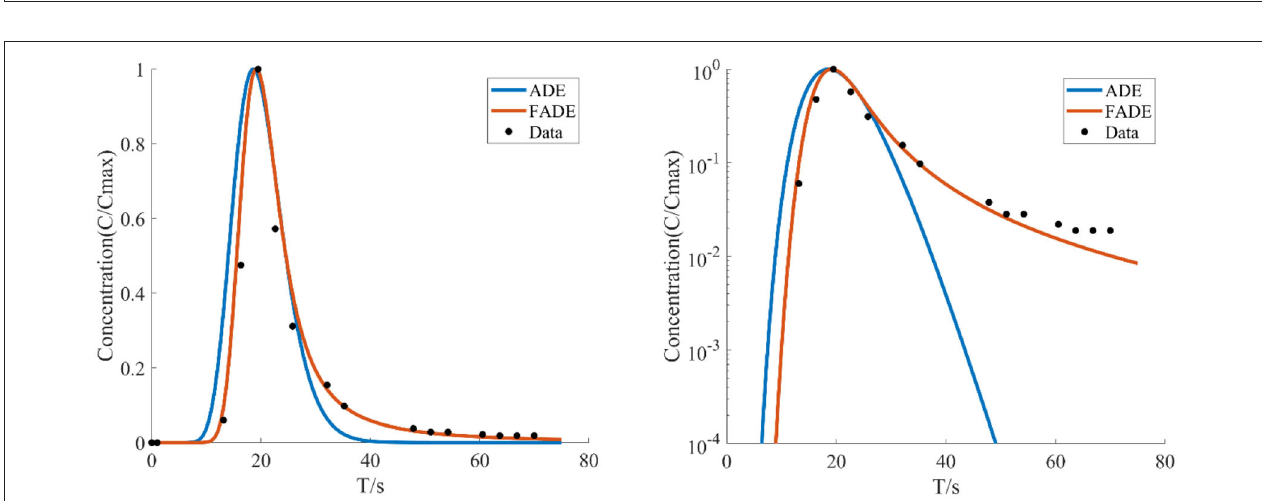
FIGURE 9 | With the average flow velocity v = 31.2064 mm/s, the average fracture width is e = 4.9mm, the concentration of the relative roughness 1 /e is 0.2041 test data, the BTCs are fitted by ADE model and FADE model.